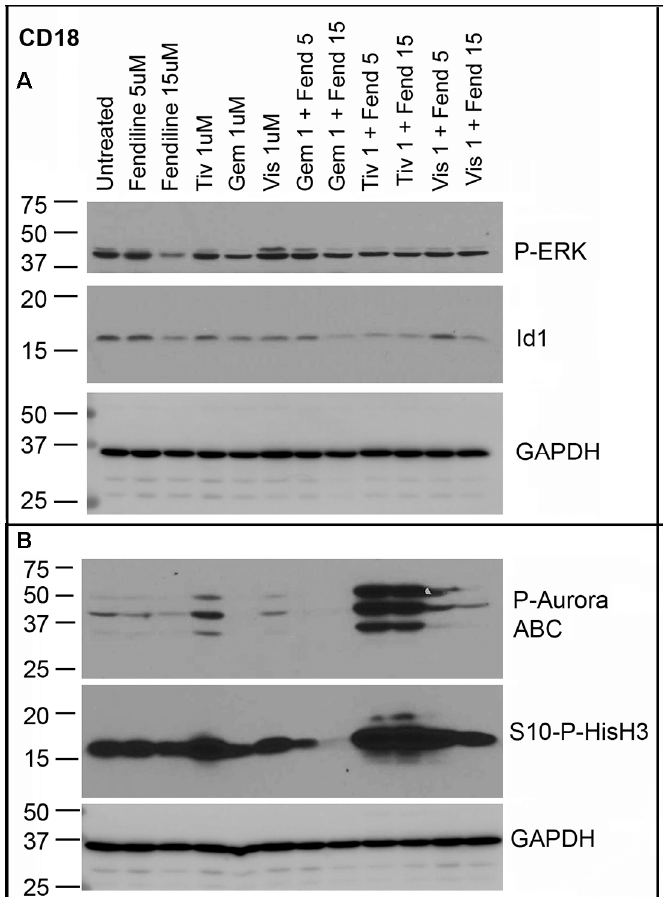
Figure 9. CD18 cells treated with fendiline alone and in combinations with the pharmacological agents show altered expression of proteins associated with proliferation, di ff erentiation and cell cycle: CD18 cells treated with or without 5 µ M and 15 µ M fendiline alone or along with 1 µ M of tivantinib, gemcitabine or visudyne showed decreased Id1 expression ( A ), which was more prominent after co-treatment. Blots were reprobed with GAPDH for normalization of proteins. ( B ) Cells treated with tivantinib showed an increase in the levels of Phospho-Aurora ABC and Phospho-Histone H3, which were further increased upon co-treatment with fendiline. Blots were reprobed with GAPDH antibody for protein normalization.